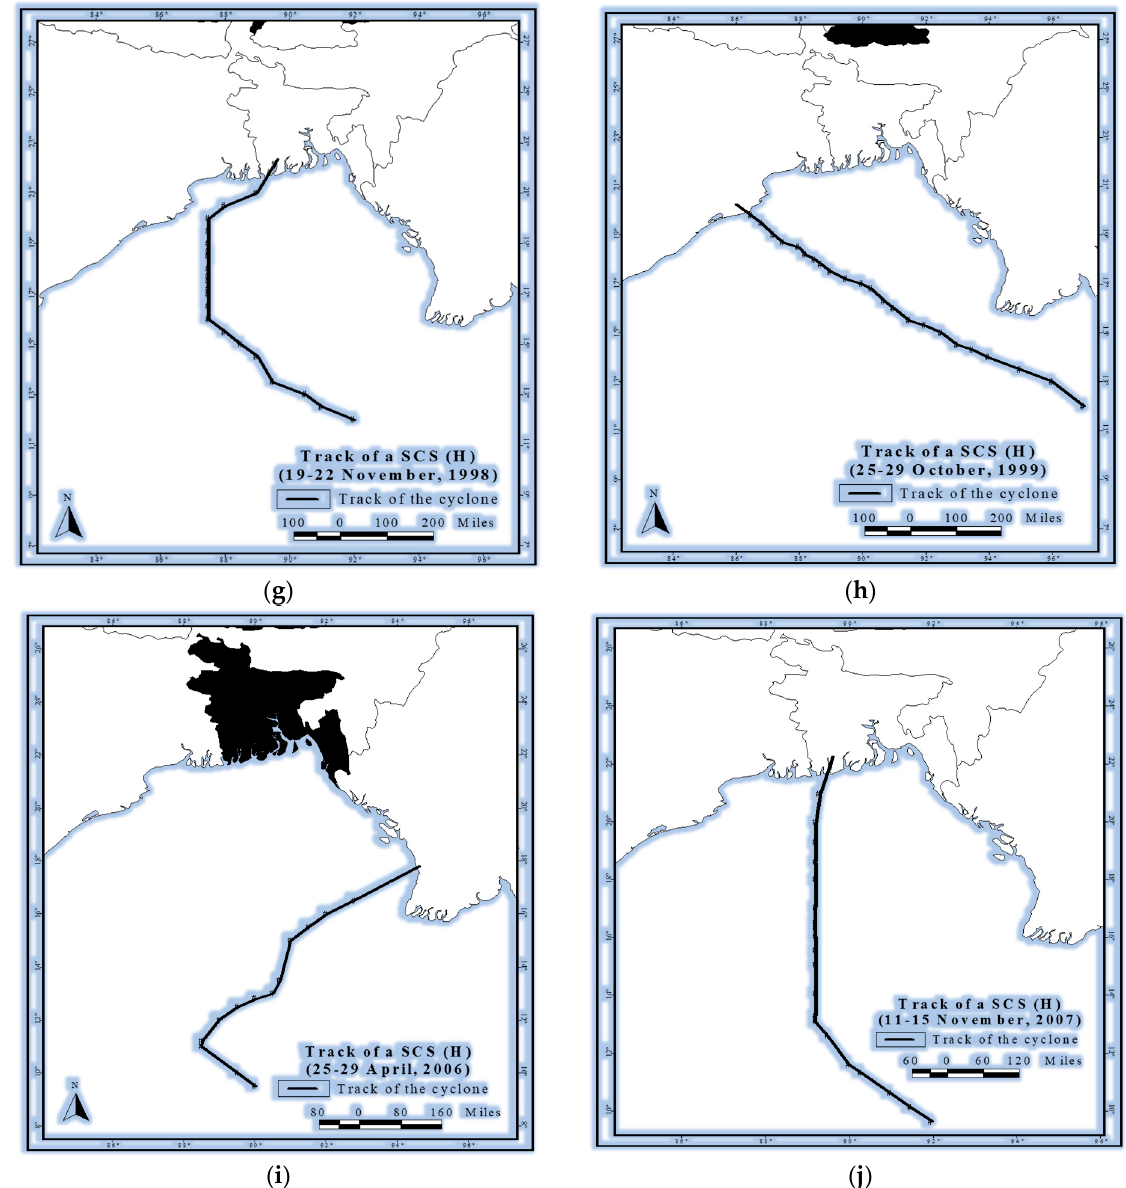
Figure 4. Ten major TC tracks in ( a ) 1981, ( b ) 1988, ( c ) 1991, ( d ) 1992, ( e ) 1995, ( f ) 1997, ( g ) 1998, ( h ) 1999, ( i ) 2006, and ( j ) 2007 over Bangladesh during ENSO. Black line and dot represent the track and movement over time. Table 4. Re-curvature analysis of the major ten cyclones over Bangladesh during ENSO.